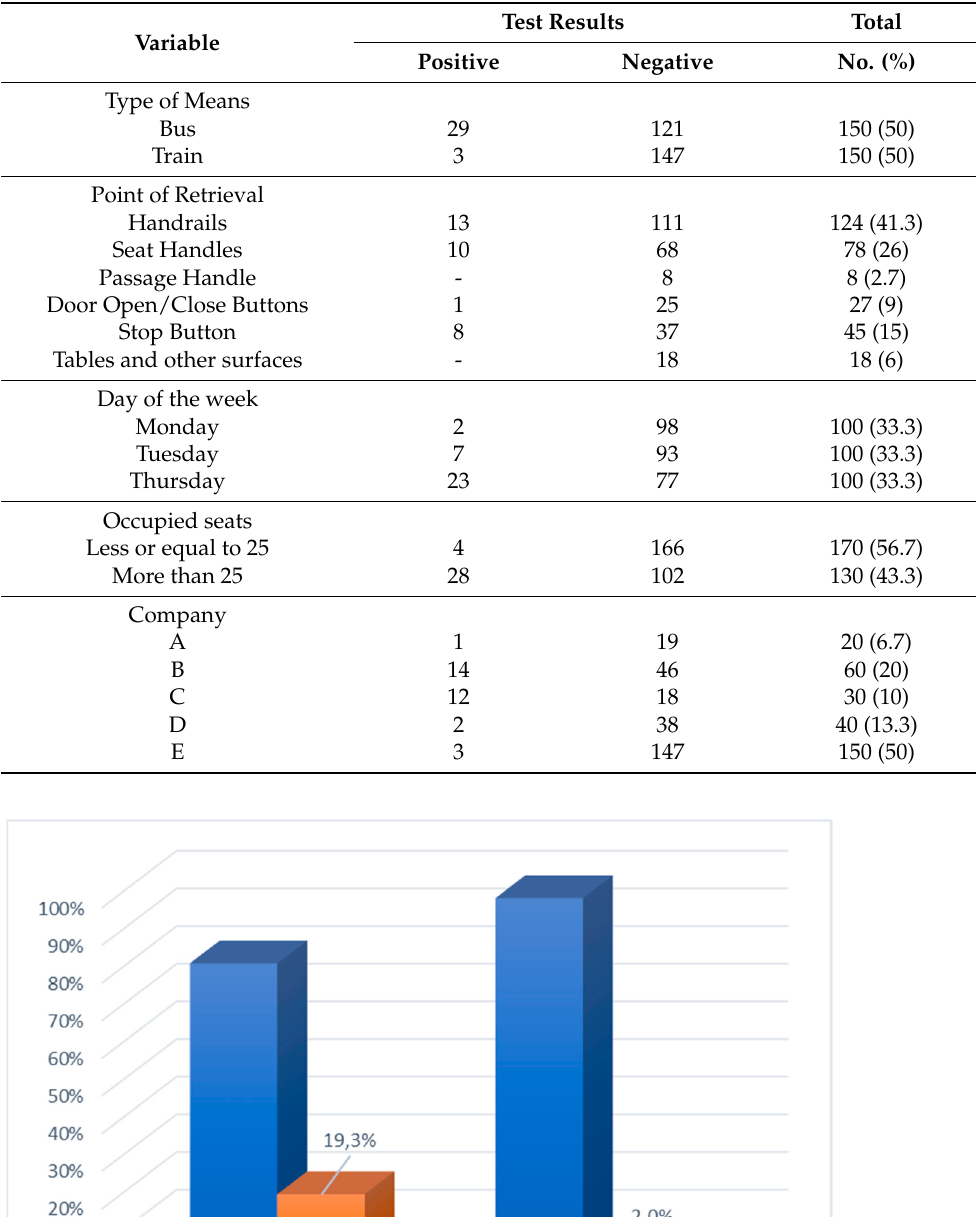
Table 1. Main characteristics of the surface samples.